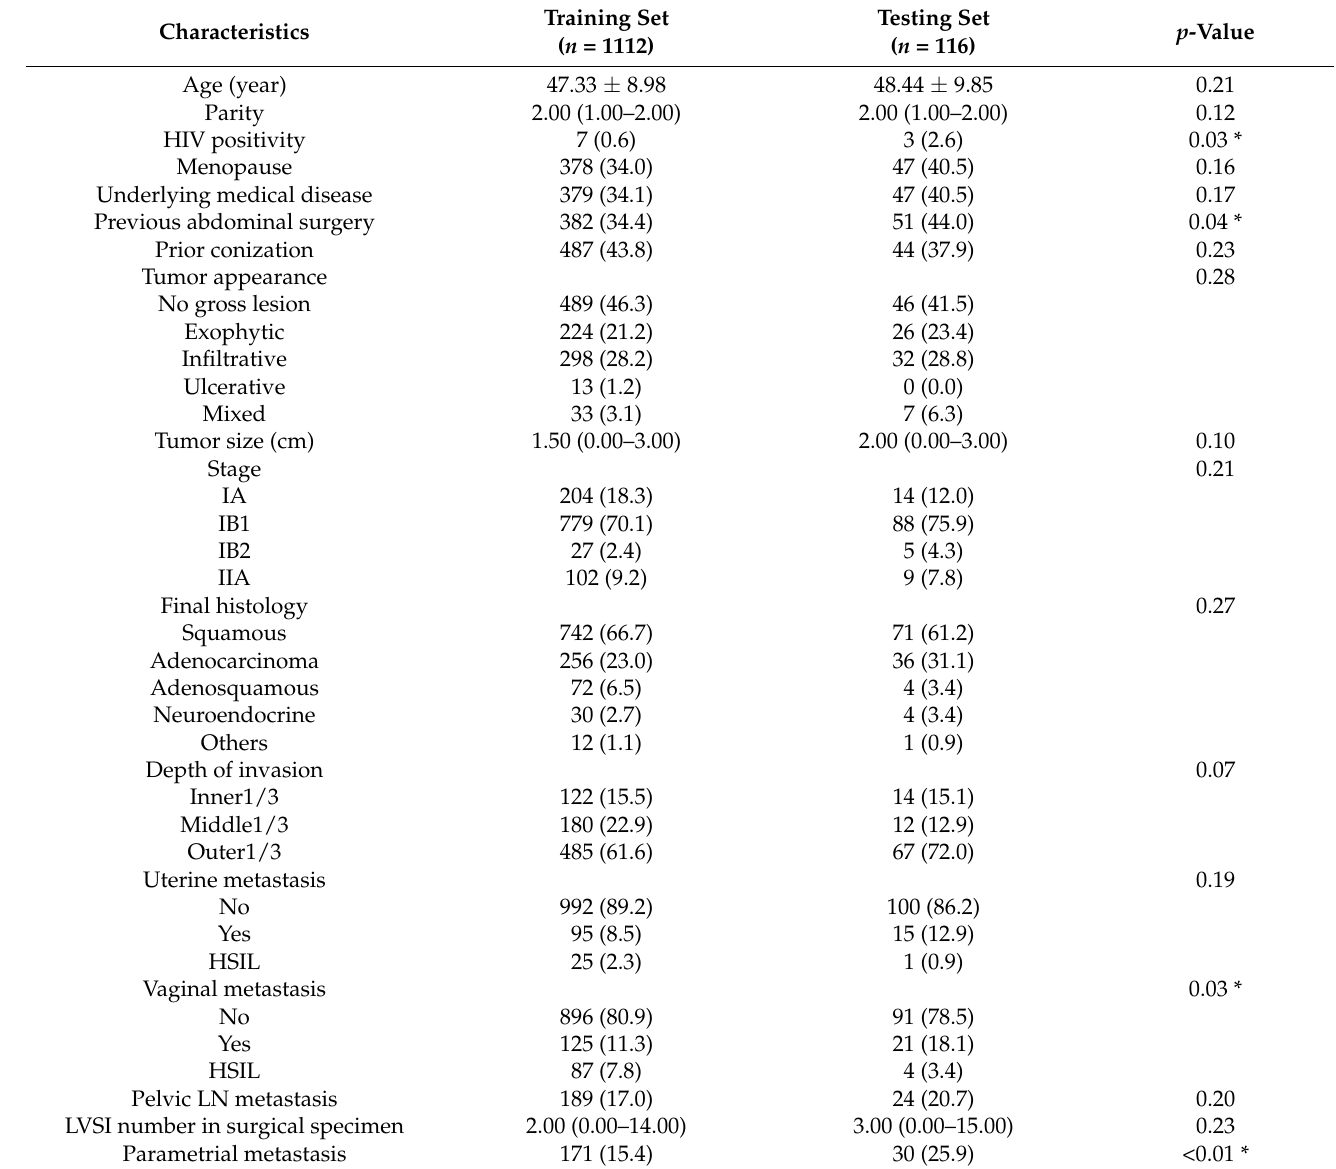
Table 1. Comparison of clinicopathological factors between the training and the independent testing dataset.